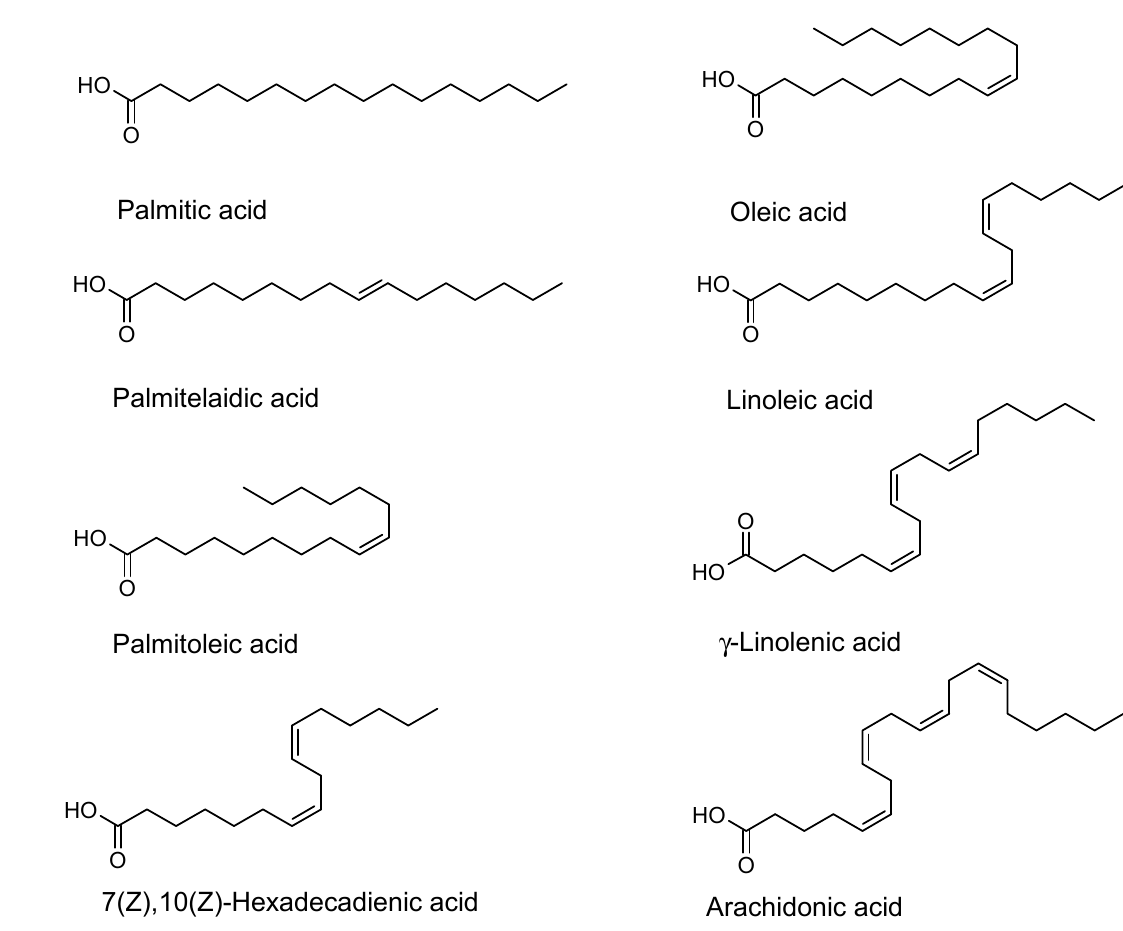
Figure 1. Fatty acids tested range from the C 16 -fatty acids palmitic, palmitelaidic, palmitoleic and 7(Z),10(Z)-hexadecadienic acid, and the C 18 -fatty acids oleic, linoleic and γ -linolenic acid to the C 20 -fatty acid arachidonic acid.